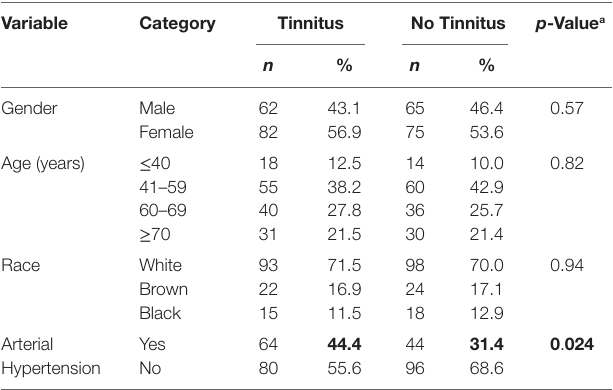
Significant values in bold. a χ 2 or Fisher test.